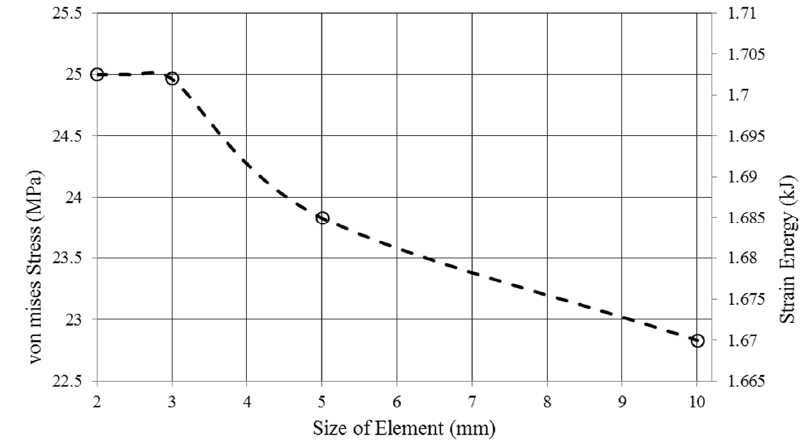
Figure 5. H-method mesh refinement based on corresponding stress and strain energy.